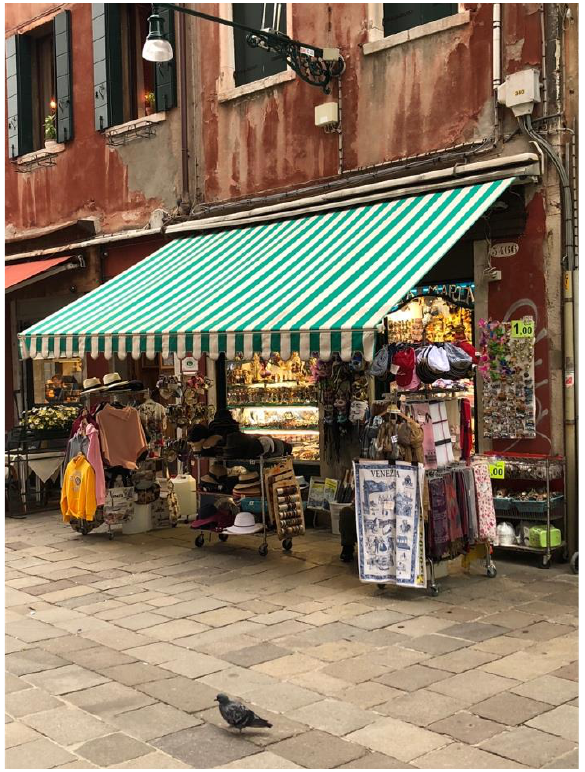
Figure 3. Shop in San Marco district. It is observed the occupation of public land with merchandise and the hanging of goods outside the shop windows (D. Perissinotto,